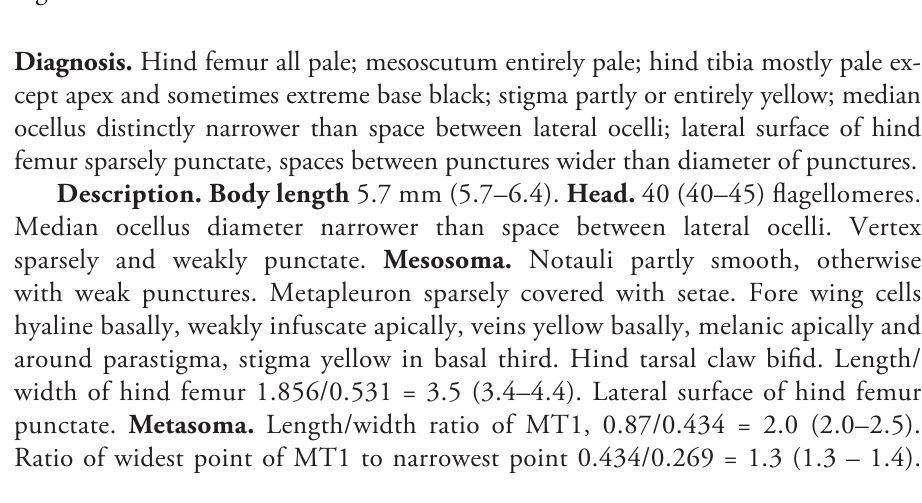
Figure 16. Zelodia surachaii sp.n. a lateral habitus b wings c dorsal head d dorsolateral head e lateral mesosoma f dorsal mesosoma g dorsal propodeum and